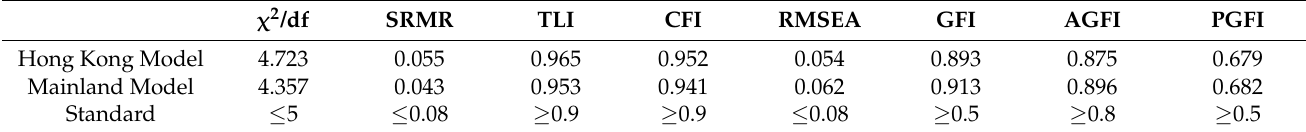
Table 6. Model fit indexes for SEMs of Hong Kong and Mainland China.